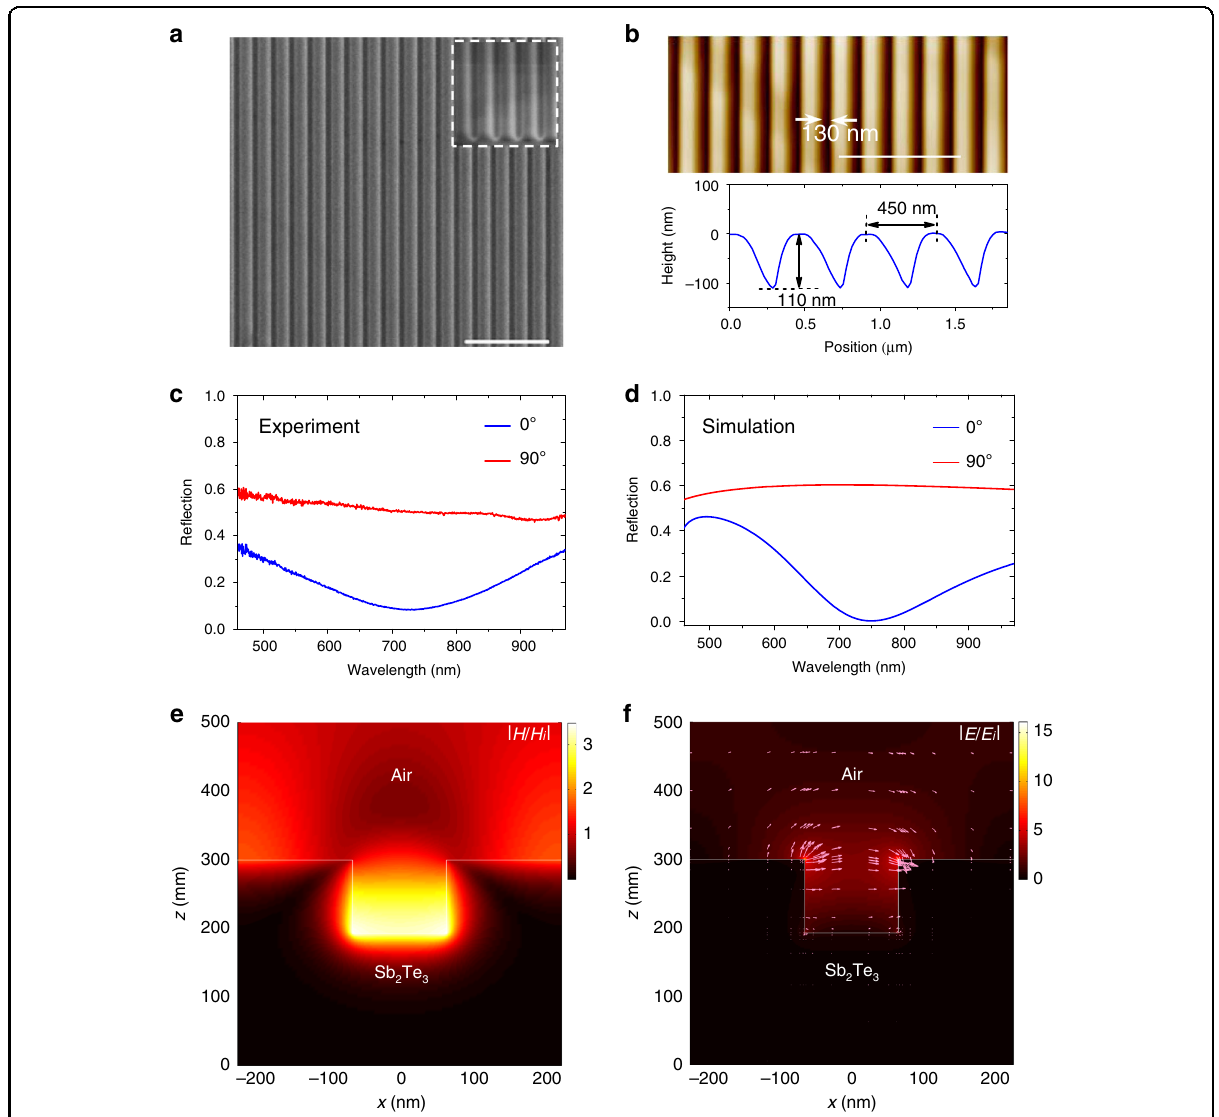
Fig. 2 Structure characterization, re fl ection spectra, and MPR fi eld distribution of TI nanogrooves. a Top-view SEM image of the Sb 2 Te 3 nanogroove grating with h = 110 nm, d = 130 nm, and p = 450 nm. The scale bar is 2 μ m. The inset shows an SEM image of Sb 2 Te 3 nanogrooves with a 52-degree view. b Corresponding AFM image of the Sb 2 Te 3 nanogrooves and the nanogroove height pro fi le along the white line. c , d Experimentally measured and numerically simulated re fl ection spectra from the Sb 2 Te 3 nanogroove grating when θ = 0° and 90°. e Distribution of the magnetic fi eld | H / H i | in a periodic unit of Sb 2 Te 3 nanogrooves at the MPR wavelength when θ = 0°. f Corresponding distribution of electric fi eld. Here, H fi eld fi eld | E / E i |. The arrows indicate the directions and relative magnitudes of the electric i and E i are the magnetic and electric amplitudes of the incident light,